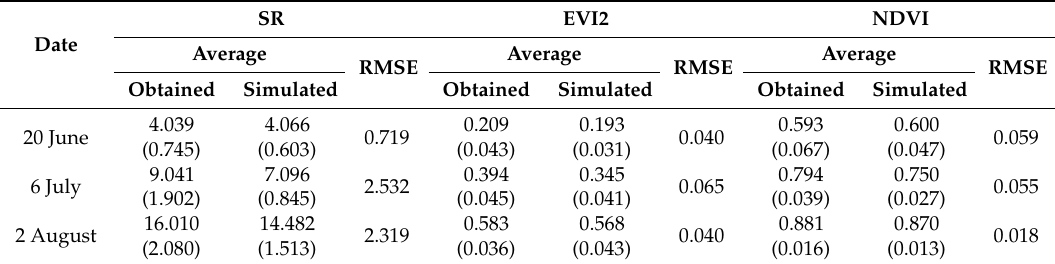
Table 3. Average of vegetation indices at measurement points (n = 80) obtained from the reflectance image and simulated by FLiES. The number in parentheses shows the standard deviation. RMSE was calculated from the di ff erence between the obtained and simulated